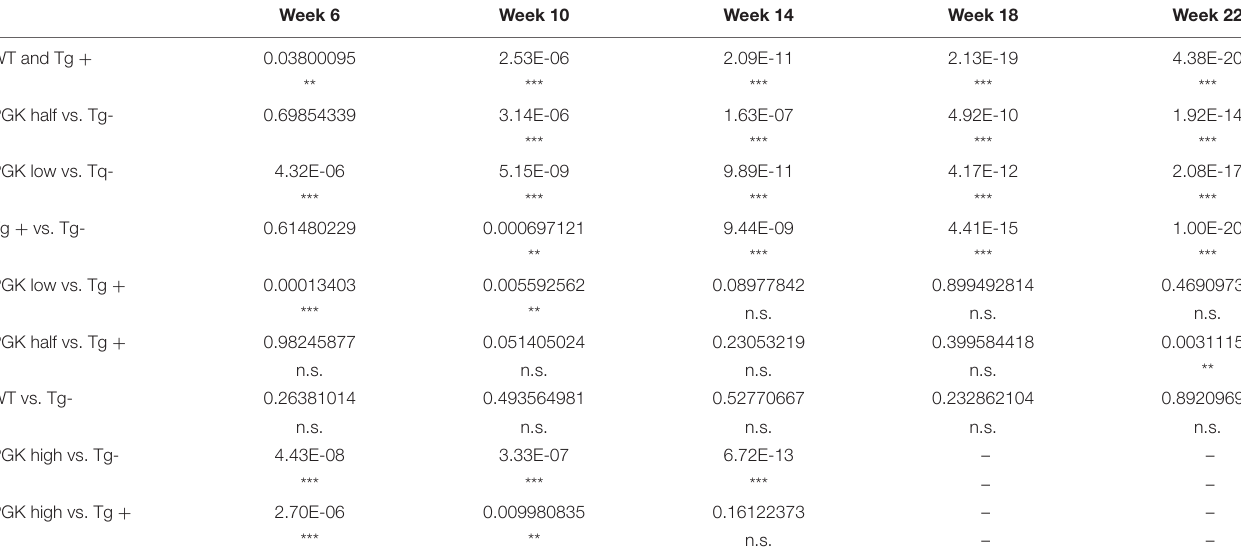
TABLE 4 | P values obtained from a two-way ANOVA on animal behavior ( Figure 9D ). Week 6 Week 10 Week 14 Week 18 Week 22 WT and Tg